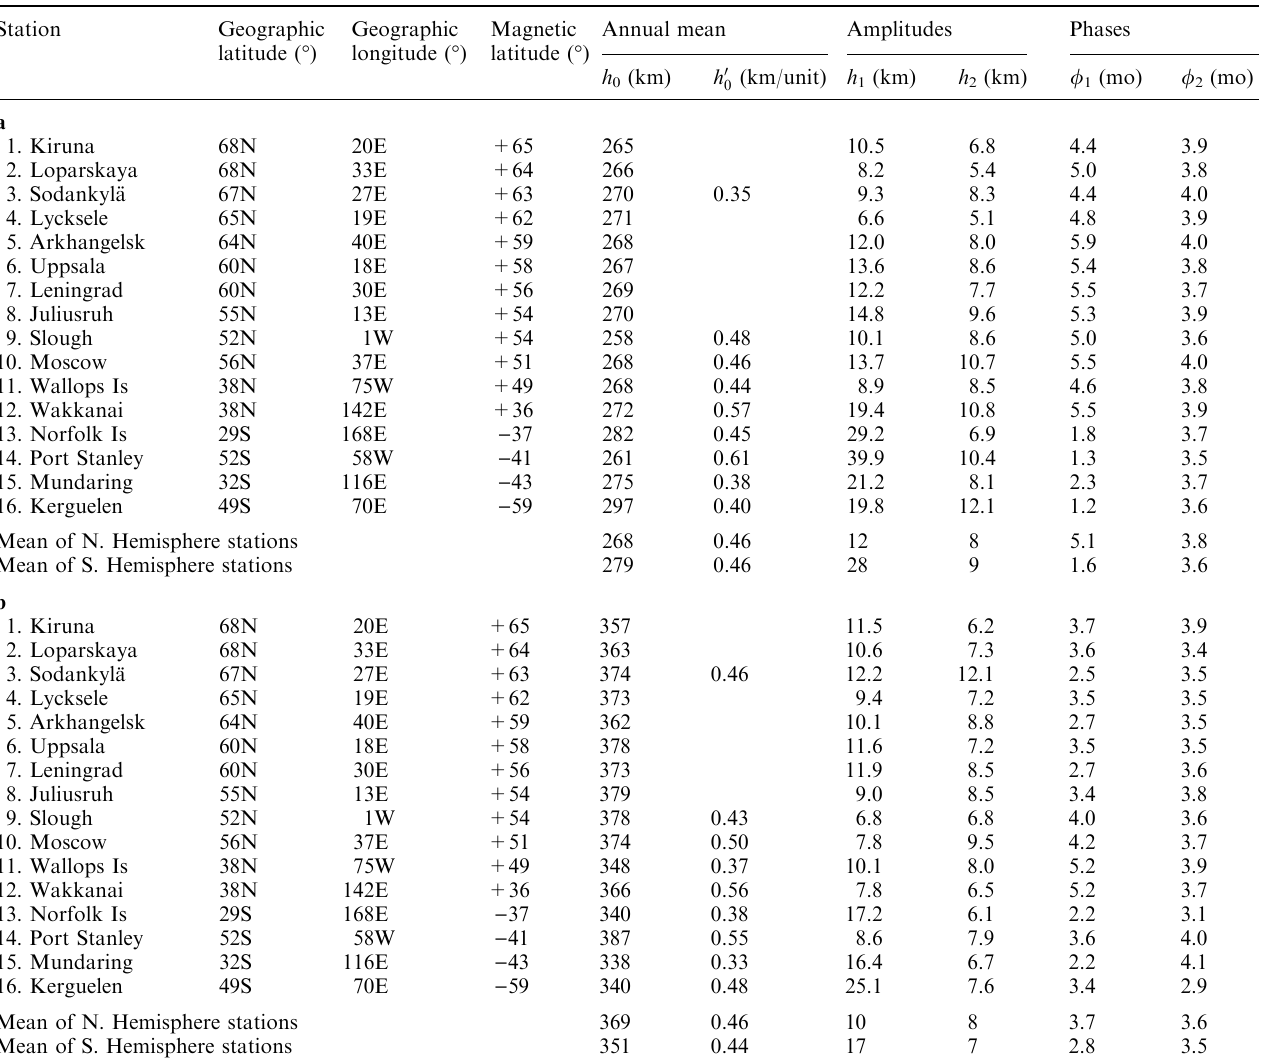
Table 1. a Height h mF2 at midday (10–14 LT) for solar flux F = 140 units, computed from ionosonde ‘‘MUF’’ data; h annual mean, h 0 is the rate of change d h 0 and h refer to the annual and semiannual components as defined 2